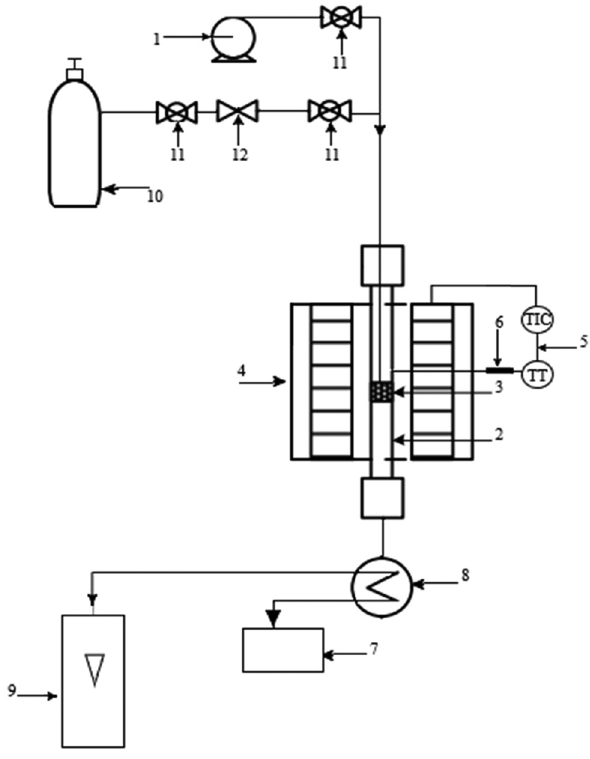
Figure 3: Schematic of the laboratory catalytic installation.